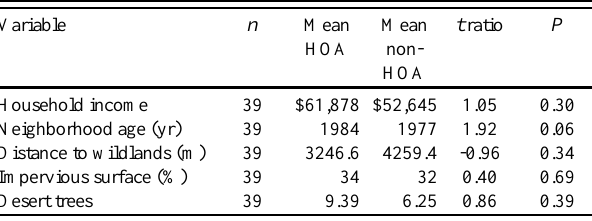
vice versa. We found no obvious patterns between bird composition and specific landscaping activities (MRPP, Table 1. Independent variables used for comparing how landscape and socioeconomic features differed between neighborhoods with different management regimes (i.e., neighborhoods with and without a HOA). Results from t test shown.